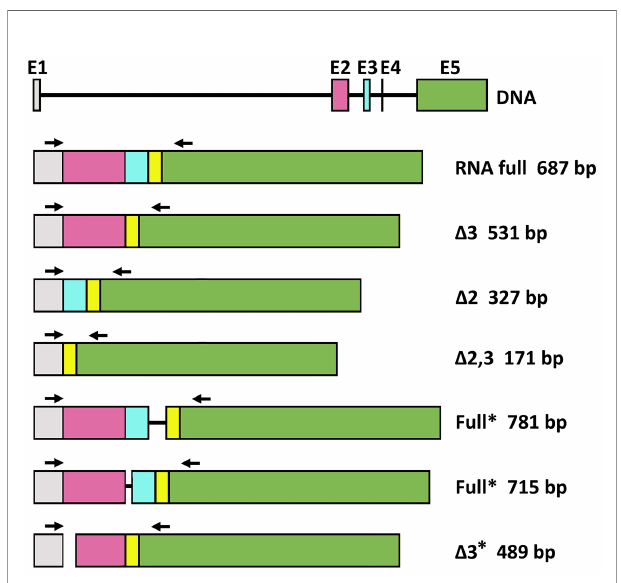
FIGURE 7 | Schematic diagram for PD1 splicing variants found in this study. fl PD-1, PD-1Dex3, PD-1Dex2, PD-1Dex2,3 with sizes about 687, 531, 327, and 171 bp, respectively. New alternative spliced isoforms that retained part of different introns, with sizes of 781 and 715 bp, and isoform with a loss of